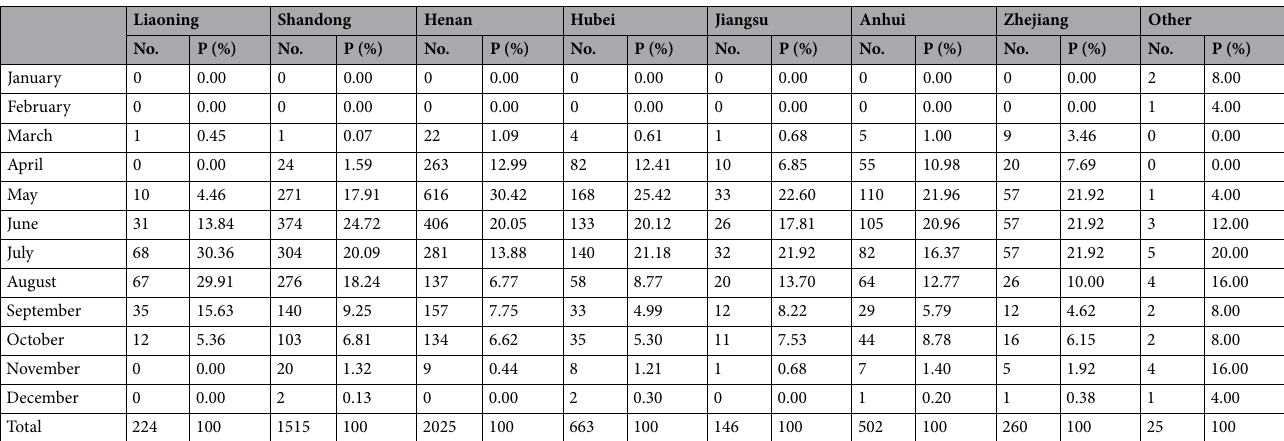
Table 2. Seasonal distribution of SFTS cases in different provinces from 2011 to 2016. * No. = Number of cases, P (%) = Proportion